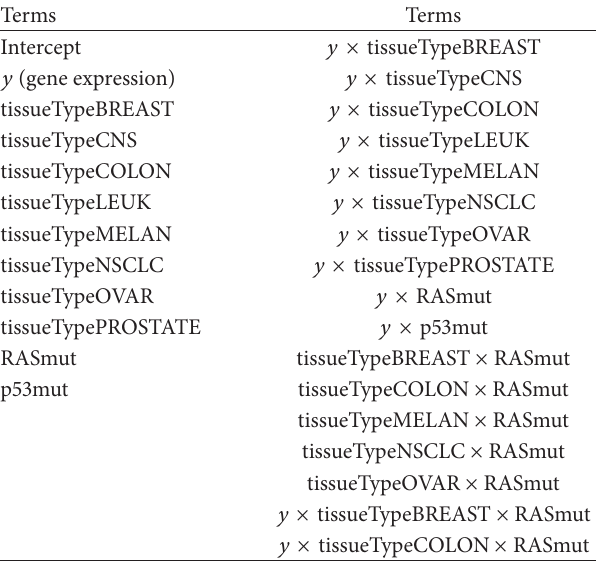
Table 1: Terms used in linear modeling. The term ( 𝑦 ) represents gene expression. The operator × represents an interaction term between two or more